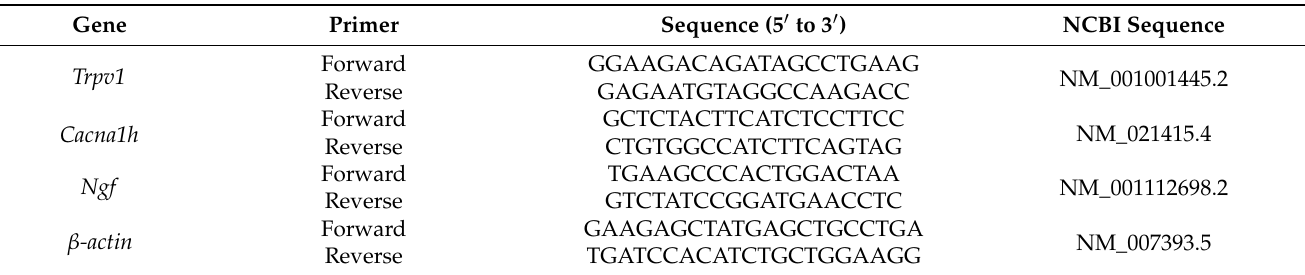
Table 1. Primer sequences for